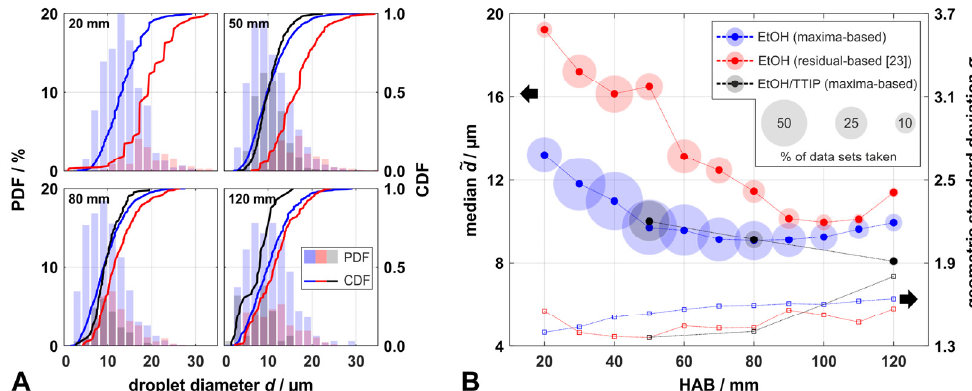
Figure 5. Comparison of results from droplet sizing at an EtOH spray flame using the novel maxima-based method (blue colored plots) and the residual-based method of our previous work [23] (red colored plots); results from a particle-laden EtOH/TTIP spray flame are additionally shown in grey/black. ( A ): relative number frequency distributions (PDF) and their cumulative distributions (CDF) of droplets measured at the center axis of the SpraySyn flame for different HAB; ( B ): median (cid:101) d and geometric standard deviation σ g derived from droplet distributions, the diameter of the circle corresponds to the percentage of evaluable data sets at a specific HAB.